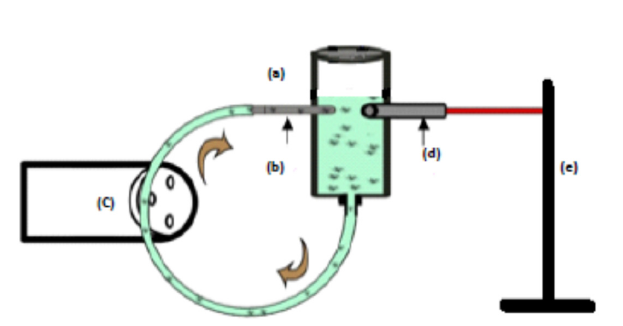
Figure 4. Abrasion-corrosion test: ( a ) Cell, ( b ) nozzle, ( c ) peristaltic pump. ( d ) The Composite Material Fly ash, ( e ) support.